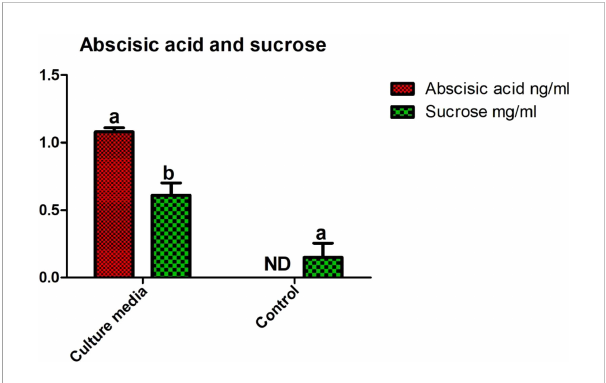
FIGURE 3 Abscisic acid and sucrose quanti fi cation in SH-8 cultured on Luria – Bertani broth. Each data point is the mean of fi ve replicates. Error bars represent the standard